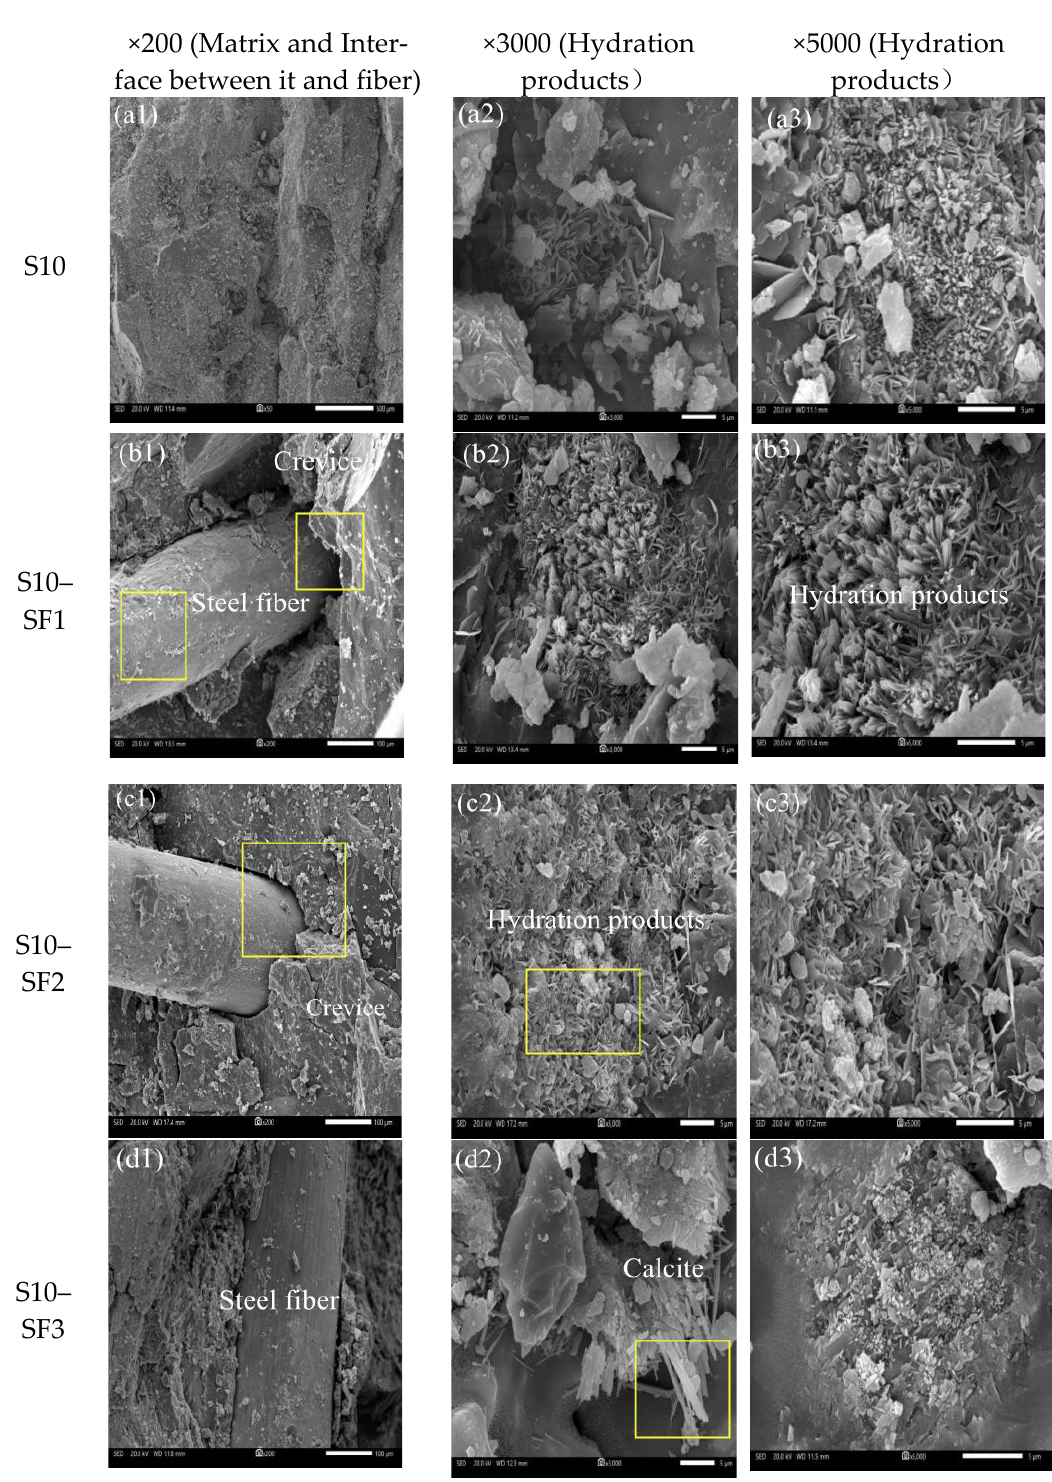
Figure 14. SEM images of AASSC with different steel fiber contents.